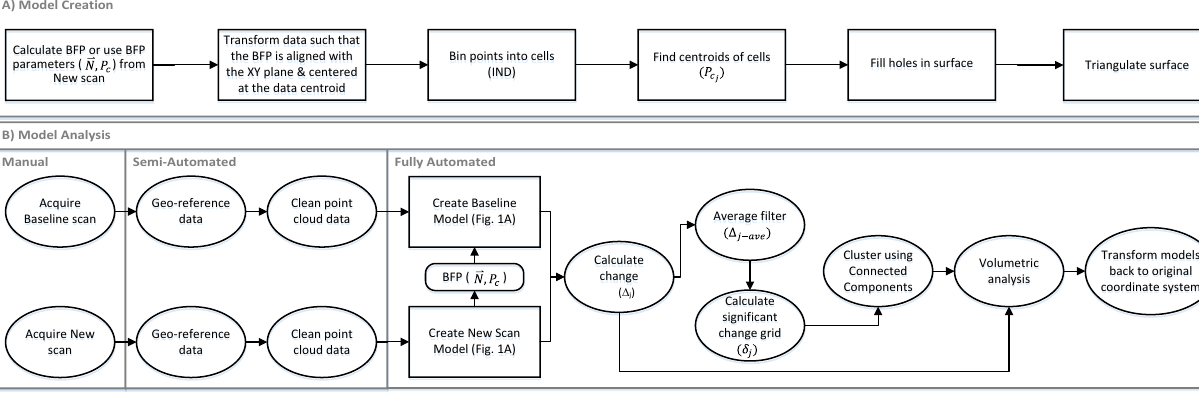
Figure 1. Flowchart of key steps of the methodology (BFP = Best Fit Plane). ( A ) Model creation; ( B ) Model analysis.